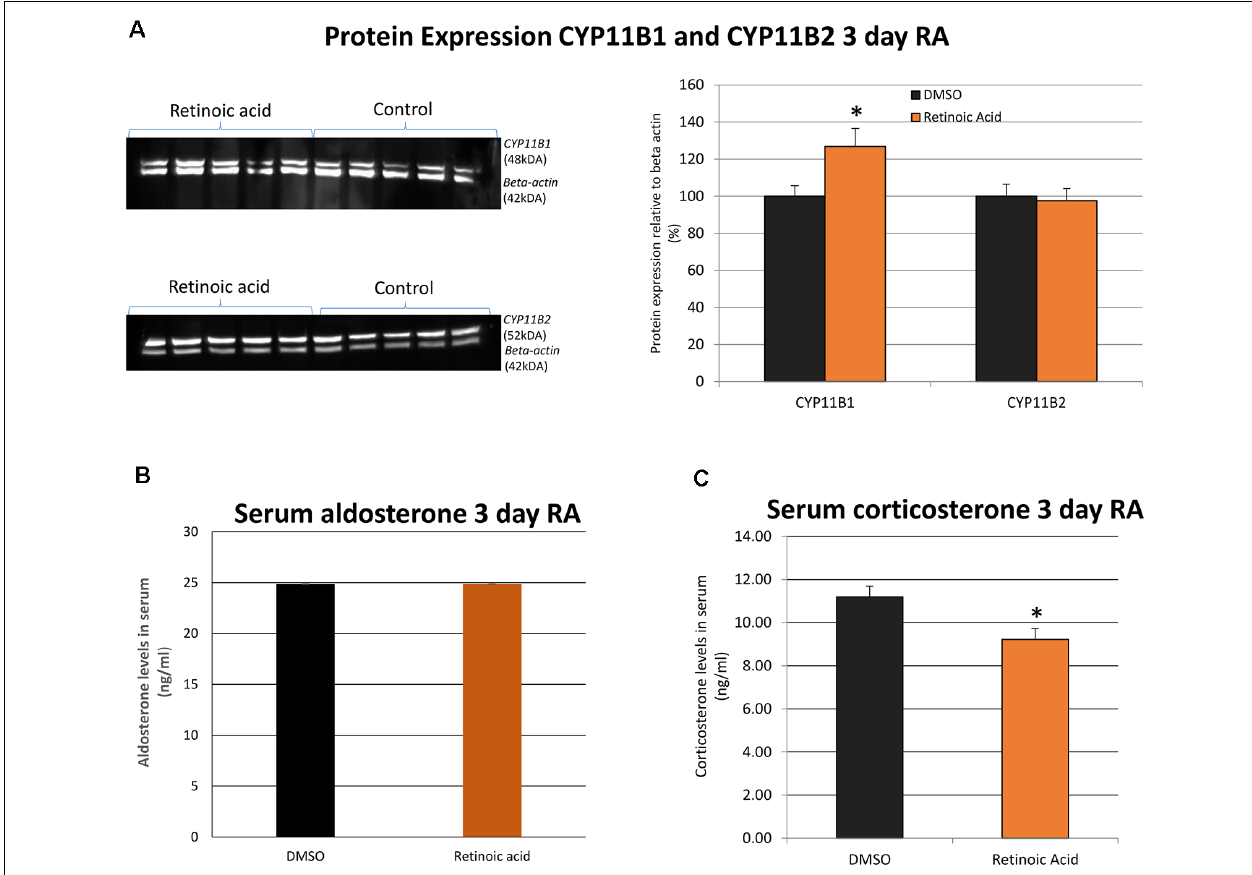
FIGURE 3 | The influence of in vivo RA treatment on adrenal gland expression of CYP11B1 and CYP11B2 protein as well as serum aldosterone and corticosterone levels. (A) Western blotting and band quantitation to determine the change in CYP11B1 and CYP11B2 relative to β -actin (imaged simultaneously) following in vivo RA treatment showed a significant increase in CYP11B1 ( p = 0.043) and no significant changes in CYP11B2 ( p = 0.798). All control values were normalized to 100%. (B) Quantitation of blood aldosterone levels with in vivo RA treatment indicated no significant change ( p = 0.221) while (C) quantitation of blood corticosterone levels indicated a significant decline in hormone after in vivo RA treatment ( p = 0.049). Significance was indicated by ∗ . N = 5 per treatment group in each case. ∗ p <